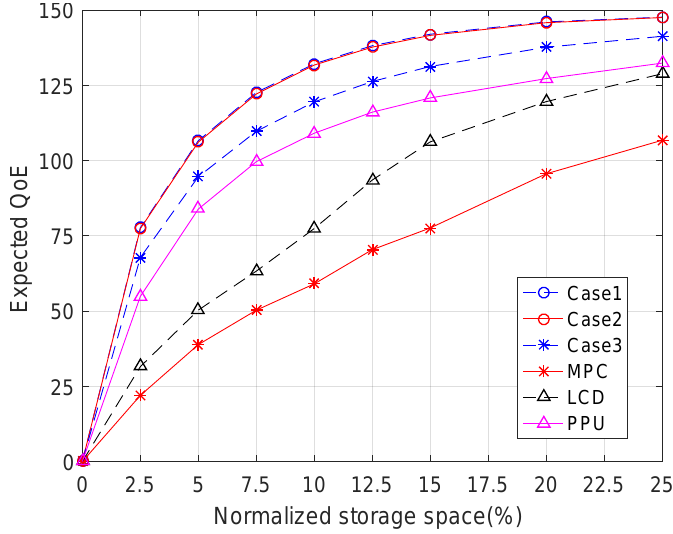
Figure 5. The expected QoE as a function of normalized storage space for different caching